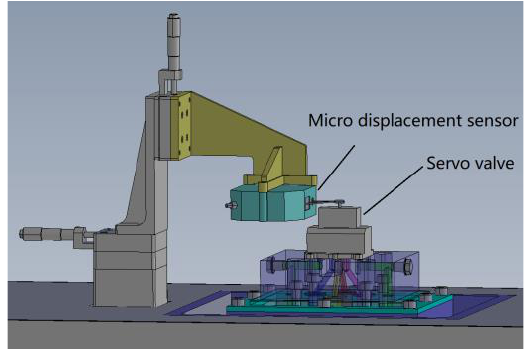
Figure 7. Schematic diagram of spool displacement measuring device. In the test experiment of the aerospace air rudder, it is unknown when the external interference occurs and how large the interference value is. Because the α parameter plays a decisive role in the control effect of the controller, we hope that the designed controller can adjust the α parameter adaptively according to the actual control error in order to achieve the best control effect. When the control error e 3 of the system is large, the value of α can be automatically adjusted to a larger value, and when the system error is small, its value can be adjusted to a smaller value, which can not only have a fast response and strong interference suppression ability, but also solve the problem of chattering well. Finally, an exponential change function is designed, as shown in Equation (39), and the influence of the c and d parameters on the function is shown in Figure 8, where β = 1.